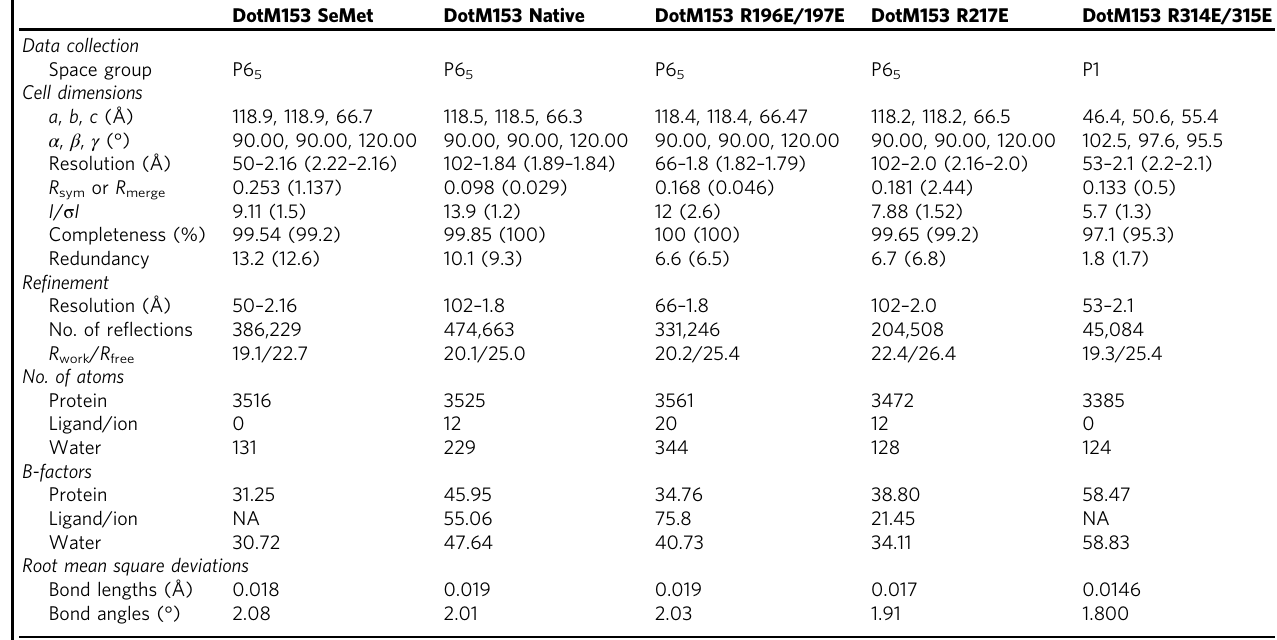
Table 1 X-ray data collection and re fi nement